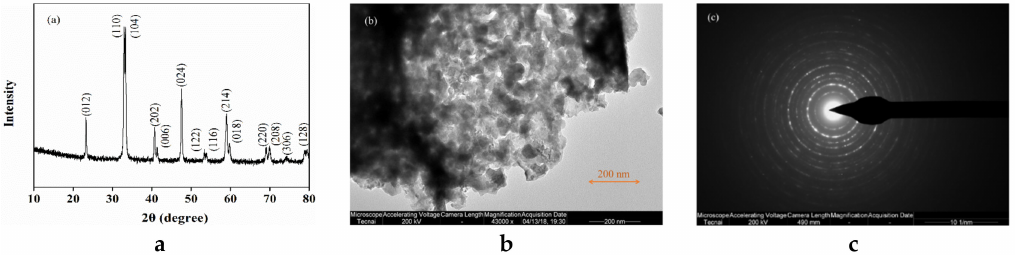
Figure 1. ( a ) X-ray powder di ff raction (XRD) pattern, ( b ) transmission electron microscope (TEM) image and ( c ) selected-area electron di ff raction (SAED) image of the LaCoO 3